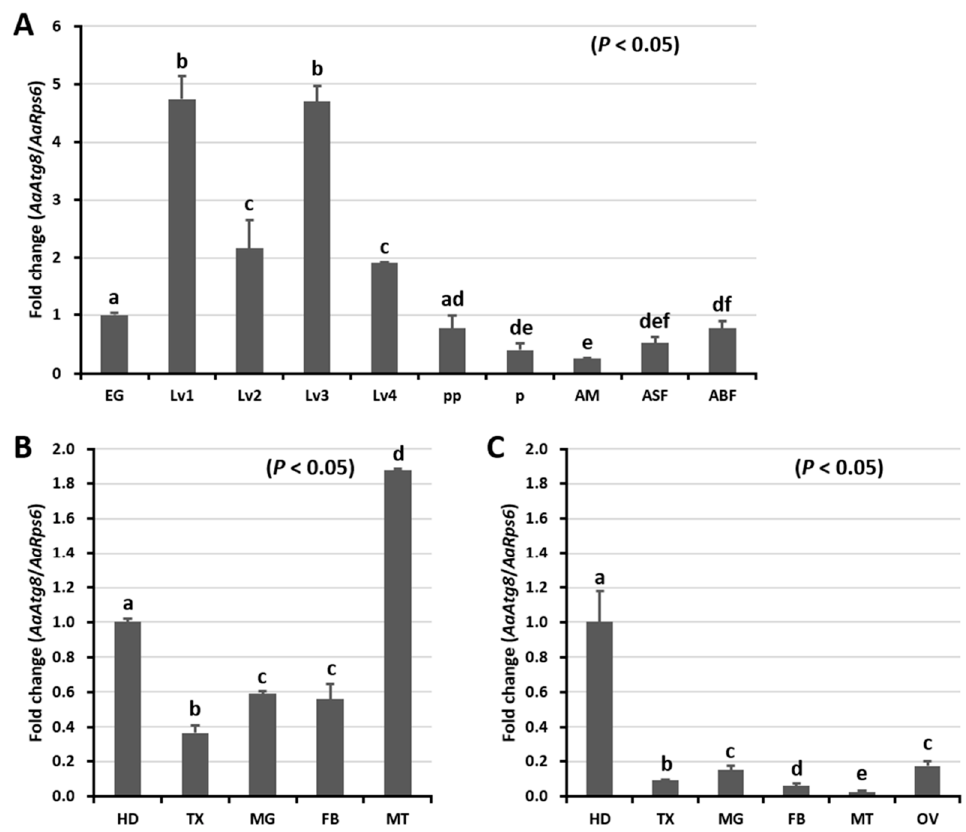
Figure 3. Developmental and tissue-specific expression patterns of AaAtg8 mRNA. ( A ) Developmental expression patterns of AaAtg8 mRNA. EG, eggs; Lv1, 1st instar larvae; Lv2, 2nd instar larvae; Lv3, 3rd instar larvae; Lv4, 4th instar larvae; PP, prepupae; P, pupae; AM, adult males; ASF, adult sugar-fed females; ABF, adult blood-fed females. Tissue-specific expression profiles of AaAtg8 in adult sugar-fed ( B ) and blood-fed ( C ) female mosquitoes. HD, head; TX, thorax; MG, midgut; FB, fat body; MT, Malpighian tubules; OV, ovary. The Ae. albopictus ribosomal protein S6 ( AaRps6 ) mRNA expression was used as an endogenous control. Data presented show the mean ± standard error. Different letters above the bars show significant differences ( p < 0.05) between groups ( n = 3).